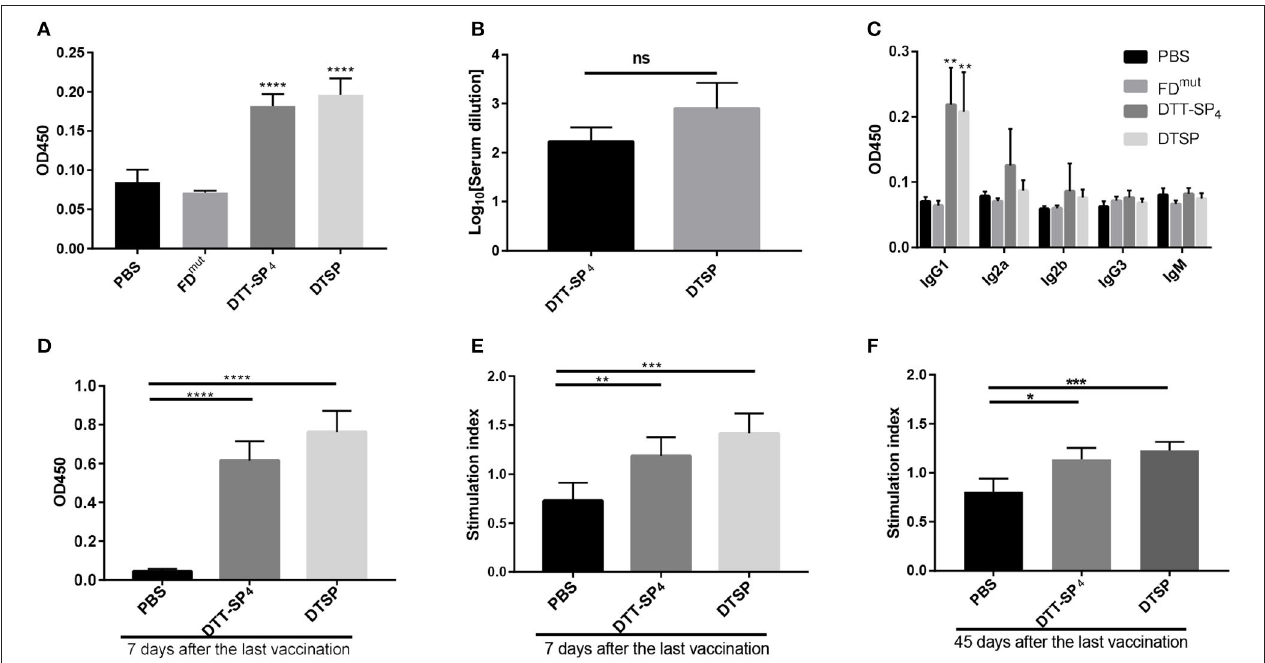
FIGURE 2 | Immunogenicity of recombinant SP antigens. (A–F) In all, 6- to 8-week-old female BALB/C mice ( n = 5) were vaccinated with DTT-SP 4 or DTSP formulated in Alum and CpG three times at 10-day intervals. (A–C) Sera were collected 5 days after the final injection to assess antibody response. (A) Total IgG antibody reaction against SP was tested by ELISA. Sera were diluted 1:100. (B) Total IgG antibody titers were expressed as logarithm 10 reciprocals of the highest dilution giving twice the absorbance of the PBS sera. Sera were serially diluted from 1:100 to 1:4,096. (C) The level of serum IgG subclass of antibodies in response to SP at a 1:100 dilution. (D–F) Splenocytes were harvested 7 days or 45 days after the third immunization and stimulated with SP for 72h in vitro . (D,E) Splenocytes were isolated 7 days after the final vaccination. (D) The absorbance of stimulated cells at 450nm in the presence of 10 µ L CCK-8 solution. (E) SIs were calculated using the ratio of the OD of stimulated cells to that of unstimulated cells at 450nm. (F) Forty-five days after the last vaccination, SI of indicated splenocytes was determined. These data are presented as means ± SD. **** p < 0.00001, *** p < 0.001, ** p < 0.01, * p < 0.05, ns, not significant, Student’s t